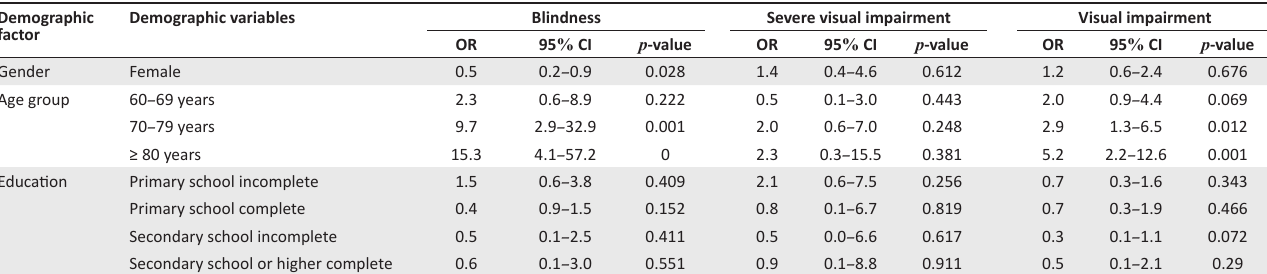
TABLE 4: Associations between age, gender and education, and vision loss. Demographic Demographic factor